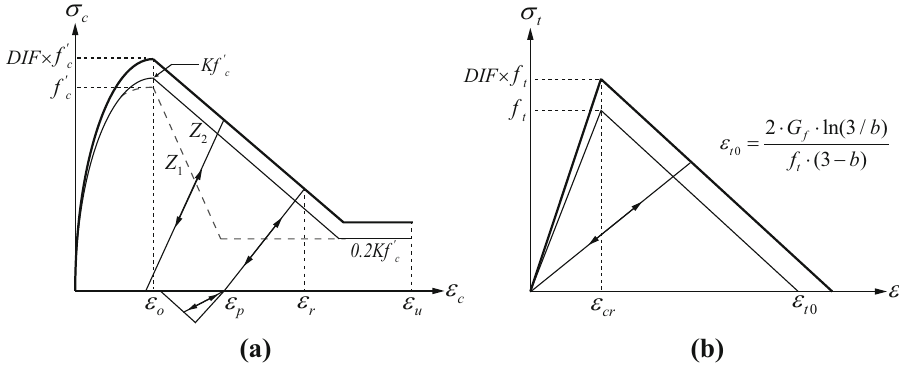
Fig. 1 Stress–strain relation of concrete. a Compression region and b tensile region.